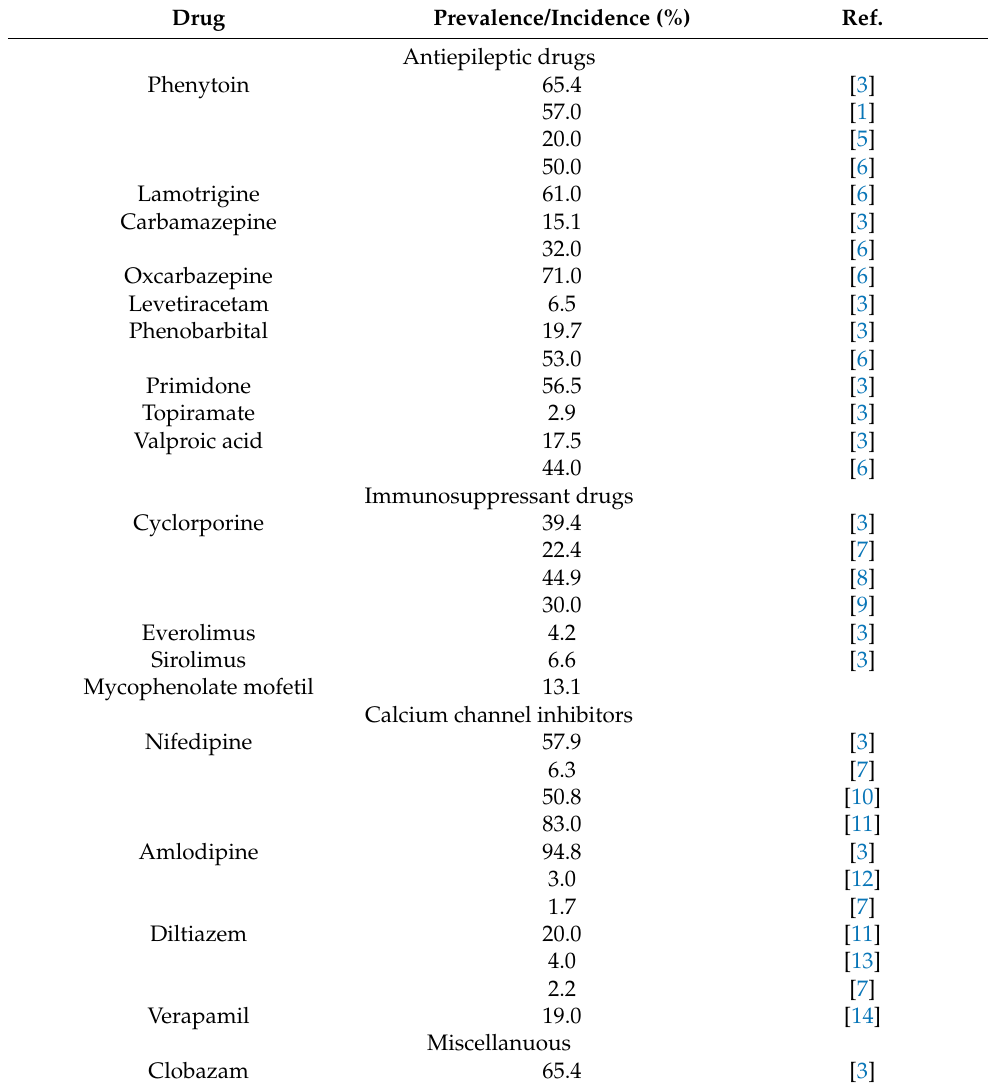
Table 1. Drug-induced gingival overgrowth.